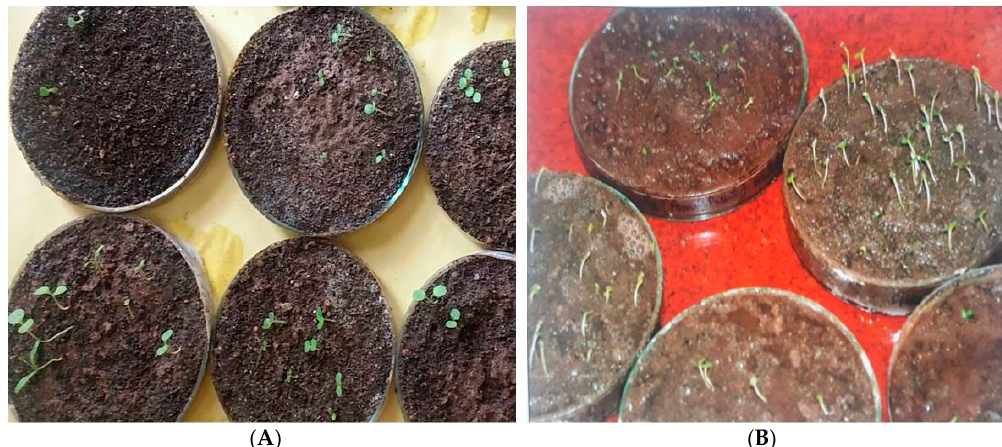
Figure 7. Valeriana wallichii : ( A ) In-situ seed germination; ( B ) ex-situ seed germination.